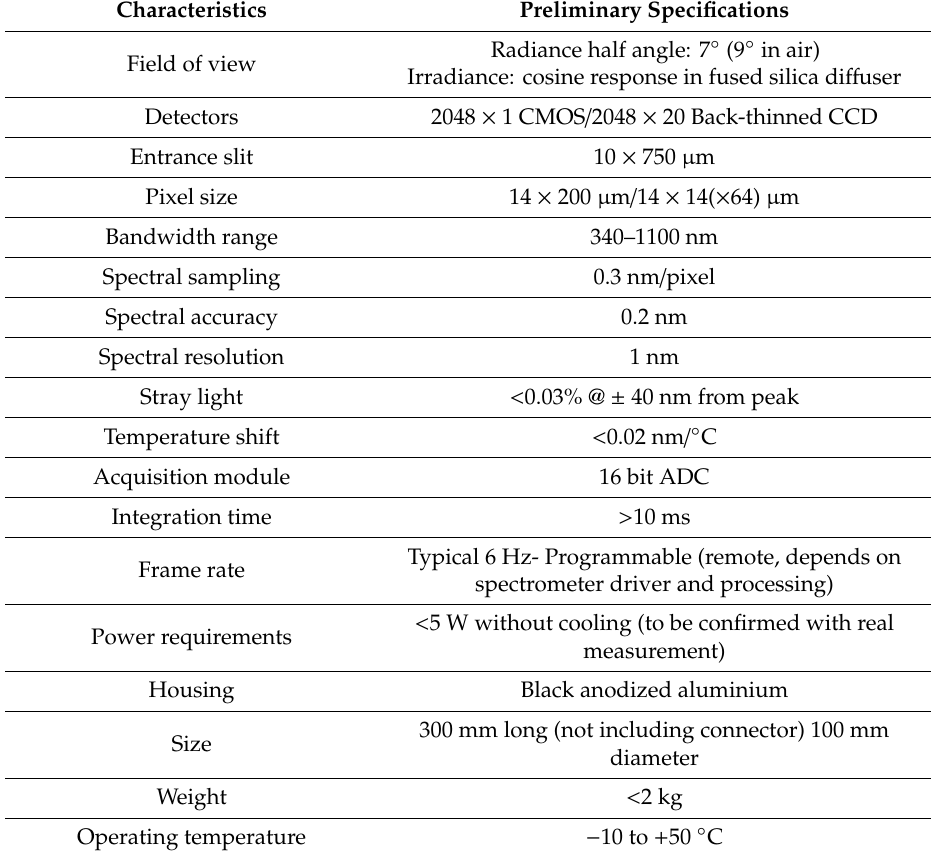
Table 3. Preliminary specification of the radiometers based on commercially available spectrometer